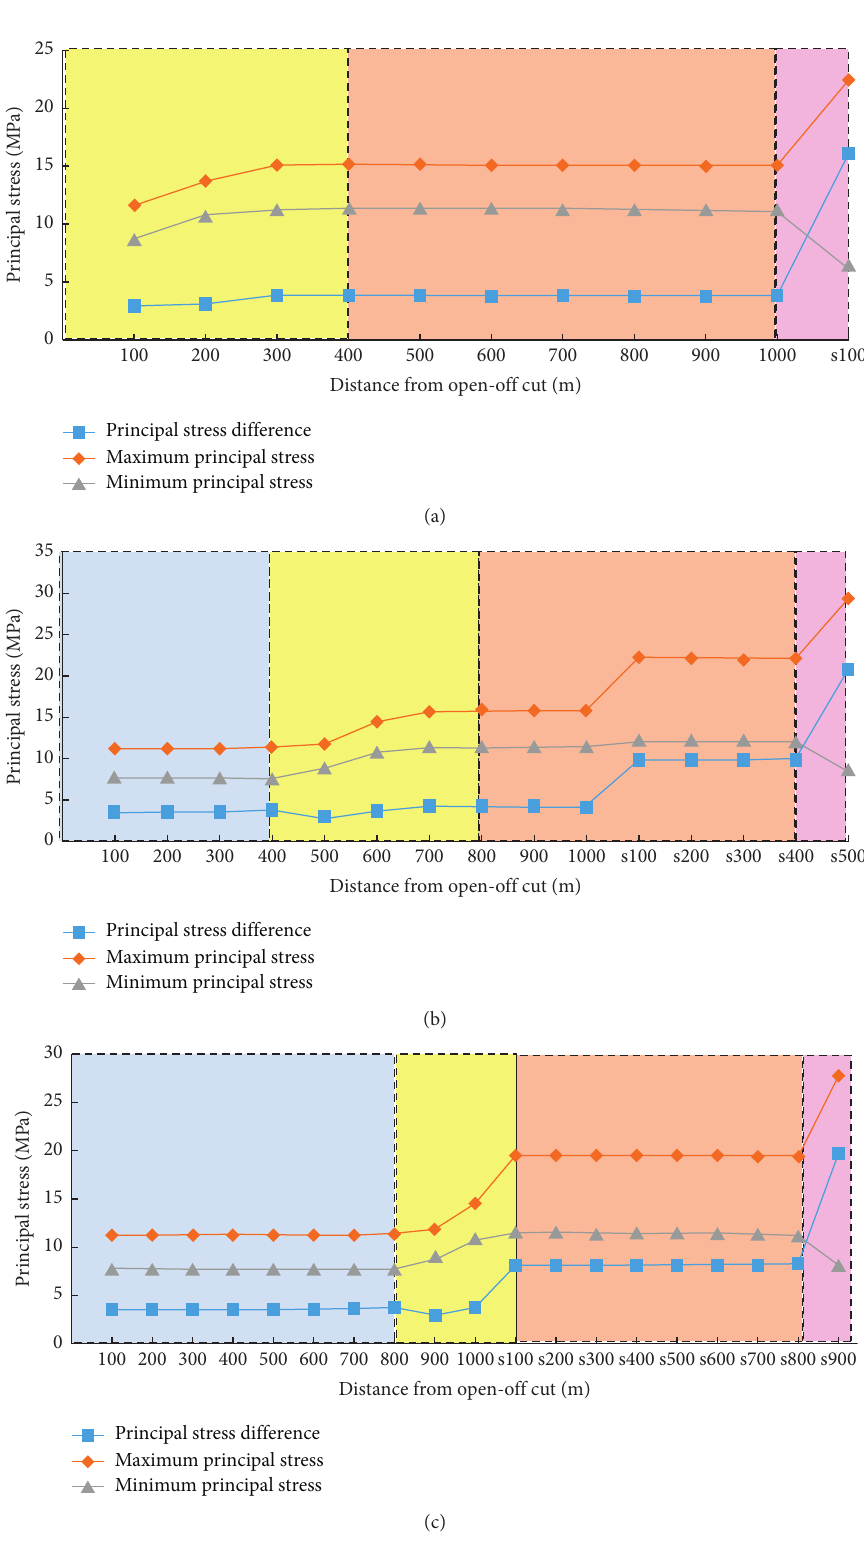
Figure 9: Stress stage diagram of each monitoring point. (a) The monitoring point. (b) The monitoring point. (c) The monitoring